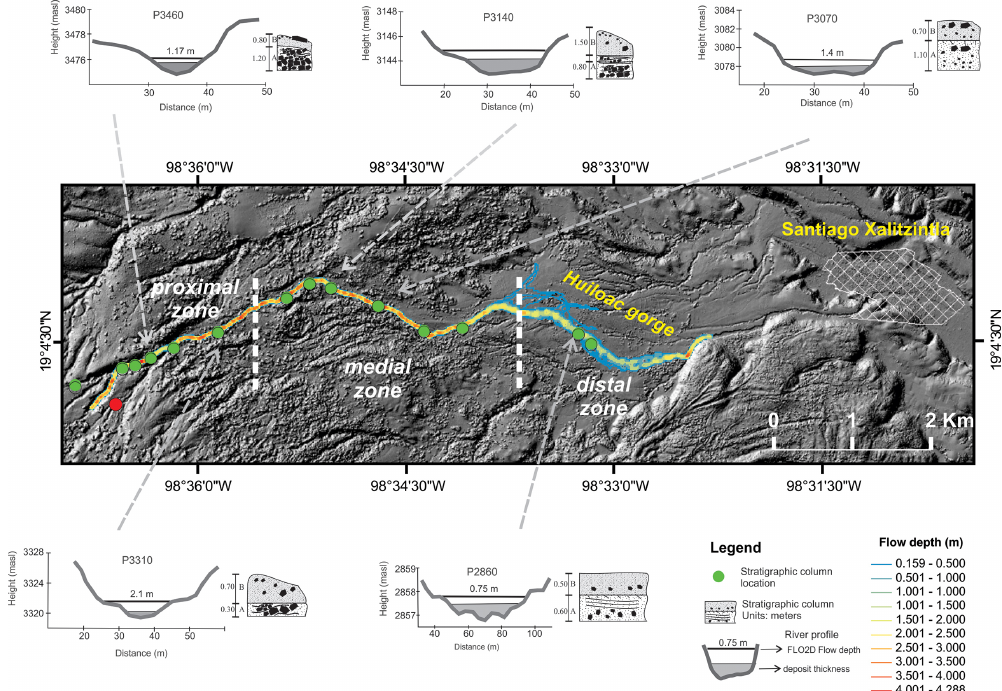
Figure 6. Simulation results of the 2001 lahar for flow depth. Green circles correspond to field data published by Capra et al. (2004). Red circle is geophone PFM3 from CENAPRED. Flow sections compare flow depths calculated by FLO2D with field data collected by Capra et al. (2004). Shaded areas represent the 2001 lahar deposit. Unit A refers to the 1997 lahar deposit and unit B to the 2001 lahar deposit.